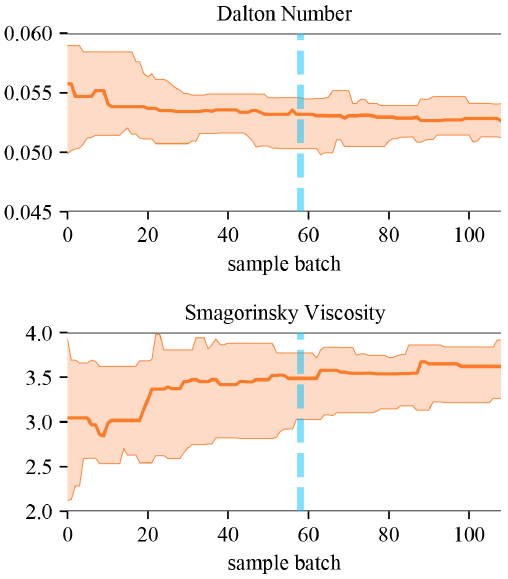
estimated in SPUX using the EMCEE sampler (see Fig. 2).